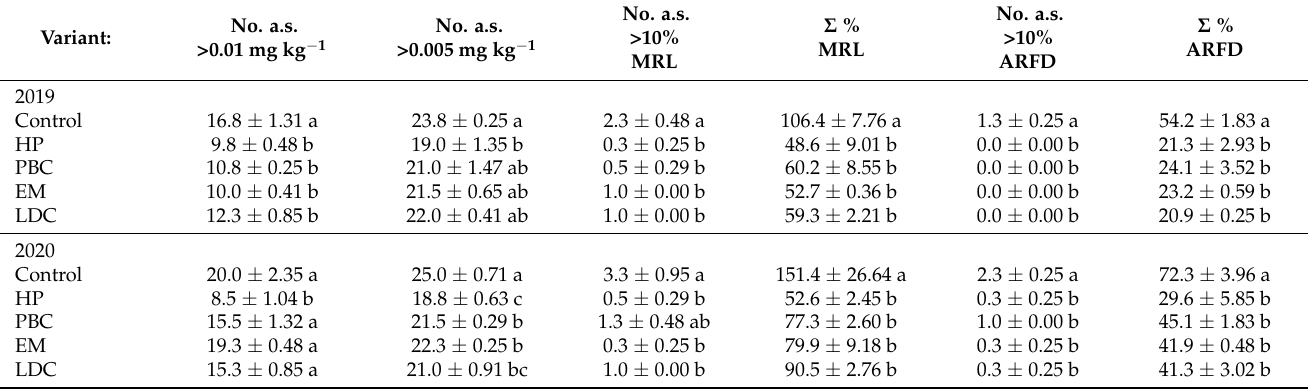
Table 6. Values ( ± SE) of pesticide residue-related parameters requested by EU supermarket